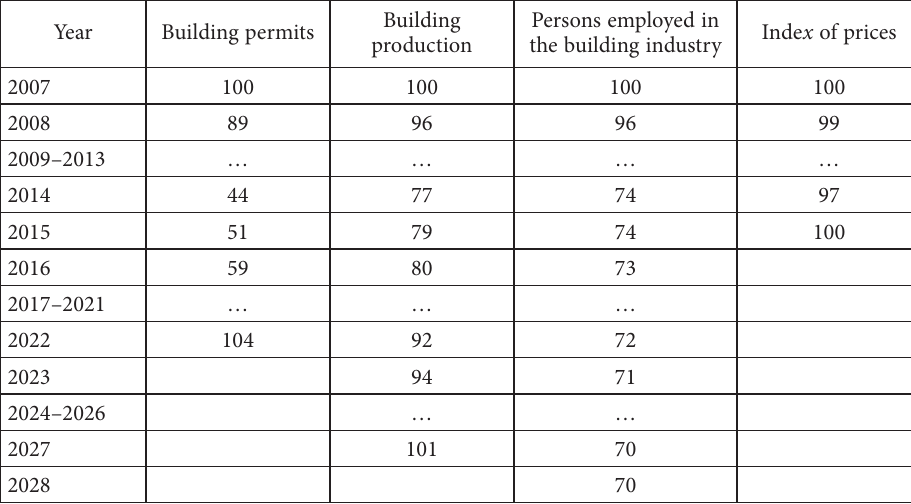
Table 2. Simulation of the accomplished development potential in the e x amined areas (source: author’s own